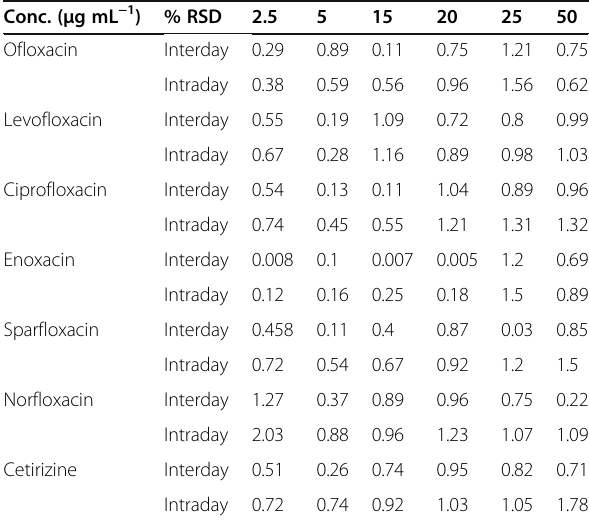
Table 4 Intermediate precision of the method